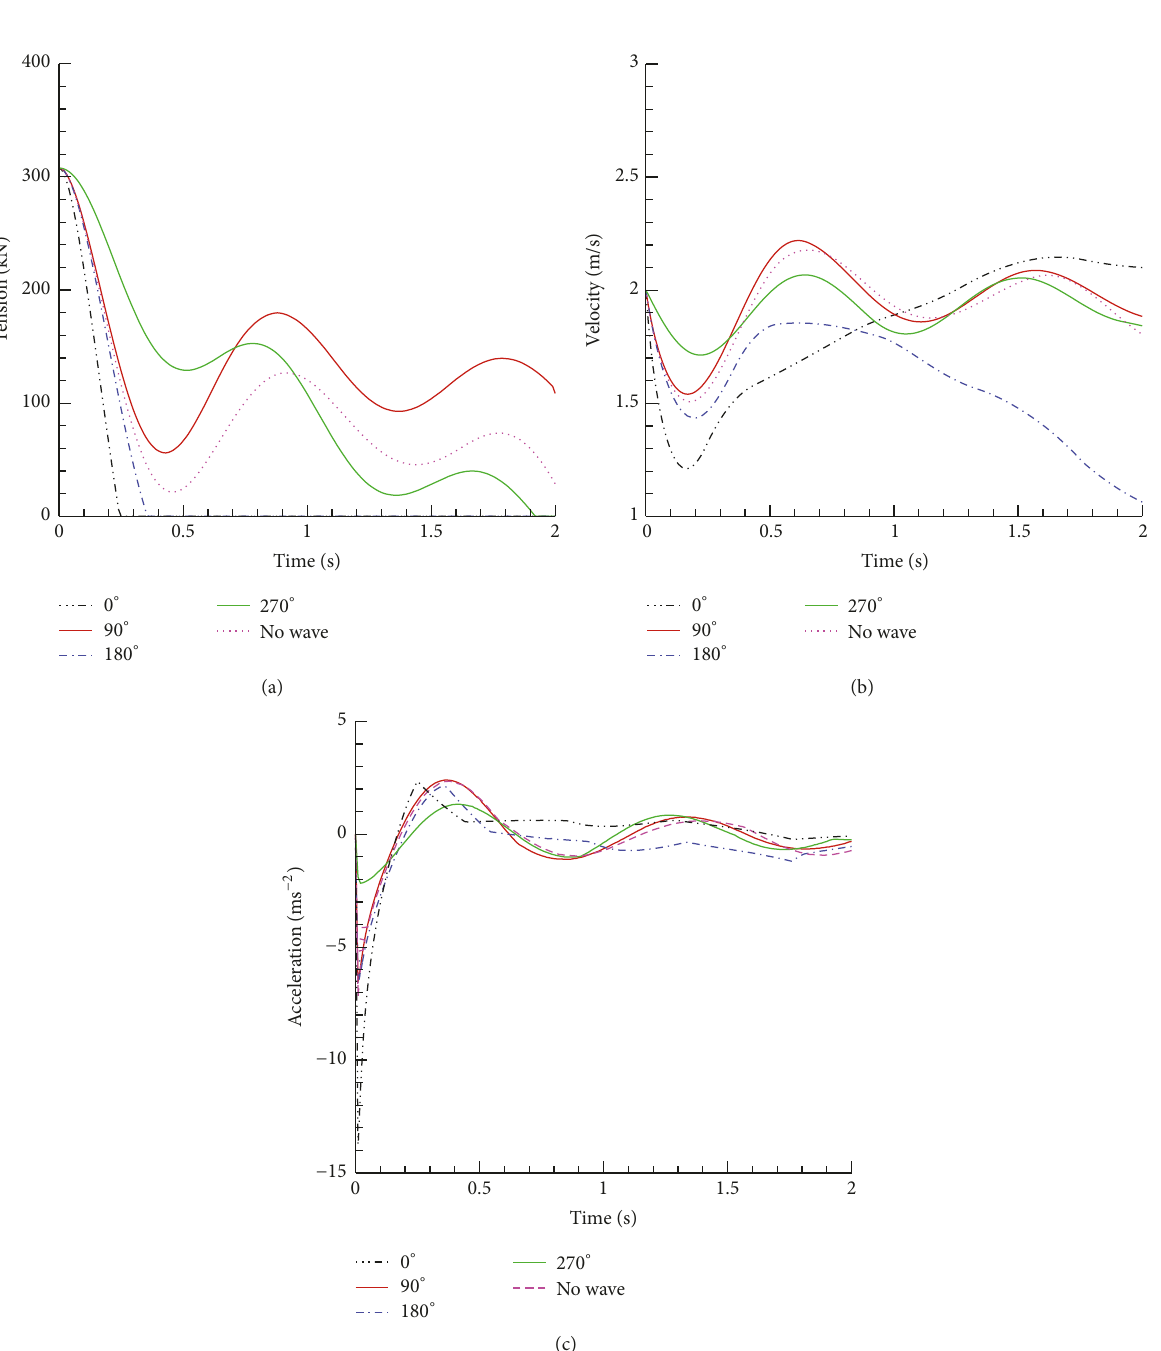
Figure 10: Influence of wave impact phase angles ( 𝑉 𝑑 = 2m/s): (a) tension acting on the cylinder; (b) velocity of the cylinder; (c) acceleration of the